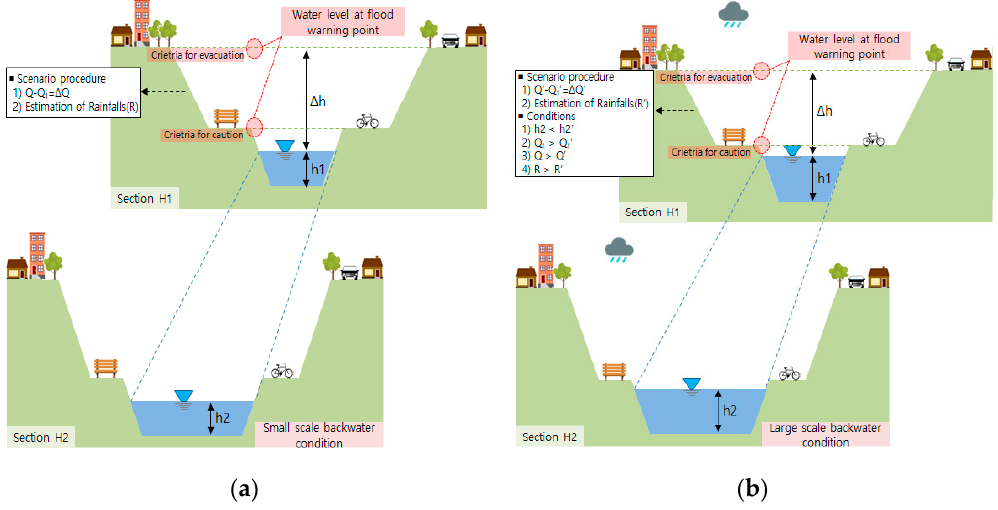
Figure 2. Rainfall threshold analysis method for flood warning. ( a ) Analysis concept of rainfall threshold, ( b ) Rainfall threshold changed according to backwater conditions. Table 1. Water level fluctuation analysis process based on upstream and downstream water level